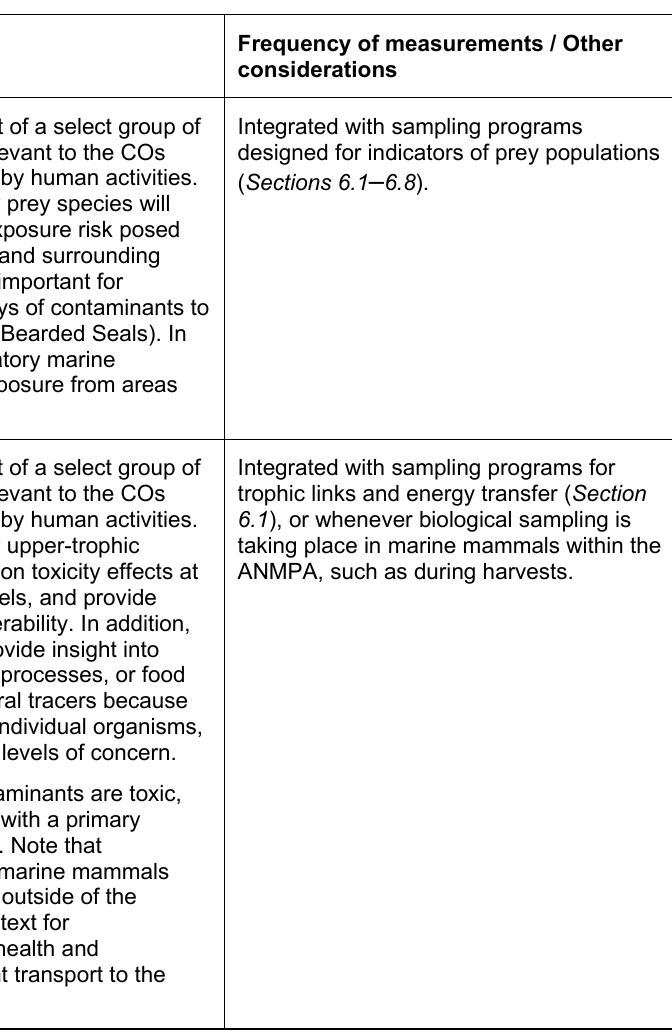
Table C7.2. Key measurement parameters for monitoring contaminant concentrations in the environment and marine mammals (Section 7.2). Note that only preliminary information is provided and additional expert advice is necessary prior to inclusion of this indicator in a monitoring plan. In addition, it may be difficult to link this indicator to the COs as contaminants may not originate within the ANMPA or are not indicative of processes occurring within the